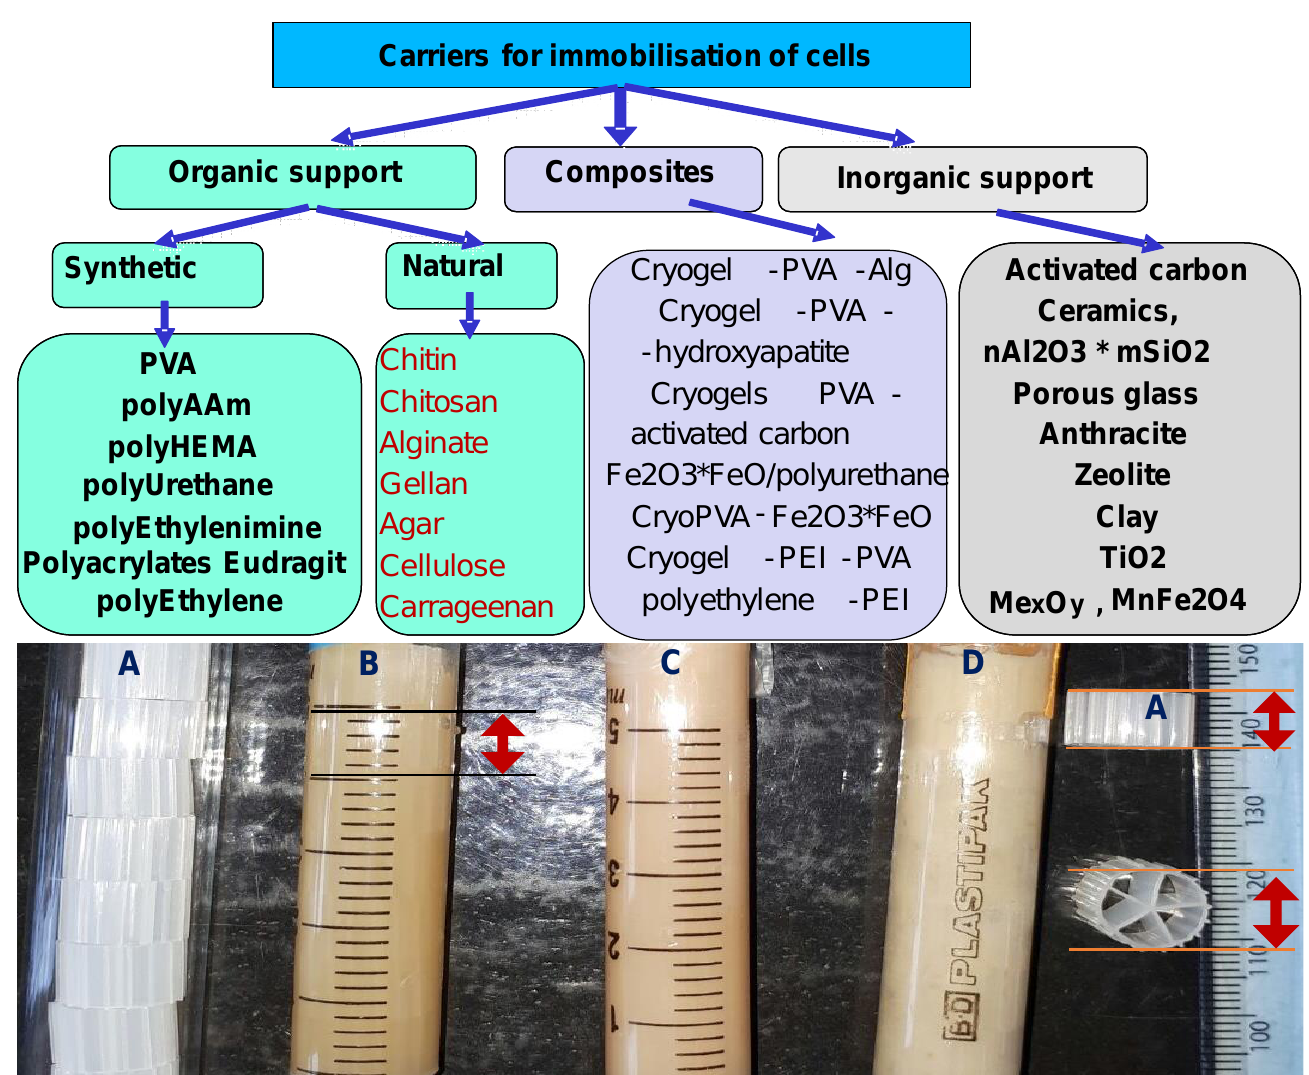
Figure 4. Immobilization carriers: ( A ) polypropylene polymeric Kaldnes carriers; ( B )composite cryogels prepared in Kaldnes carriers PVA-al-PEI-al- Pseudomonas spp. ( C ) composite cryogels prepared in Kaldnes carrier PVA-al-PEI-al- Athrobacter Chlorophrnolicus and ( D ) composite cryogels prepared in Kaldnes carrier PVA-al-PEI-al- Acinetobacter spp.